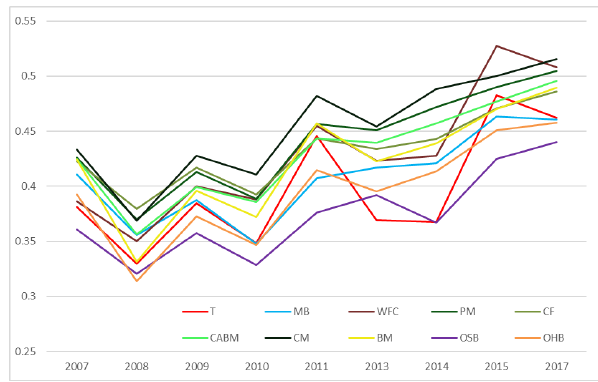
ff erent forest